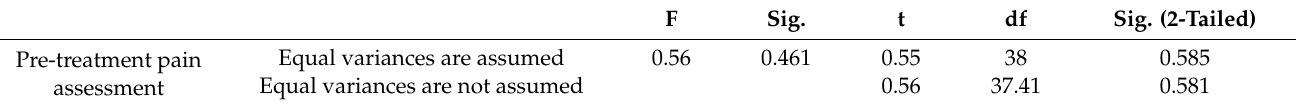
Table 1. Results of the Student’s t -test comparing the two sexes for pre-treatment pain.